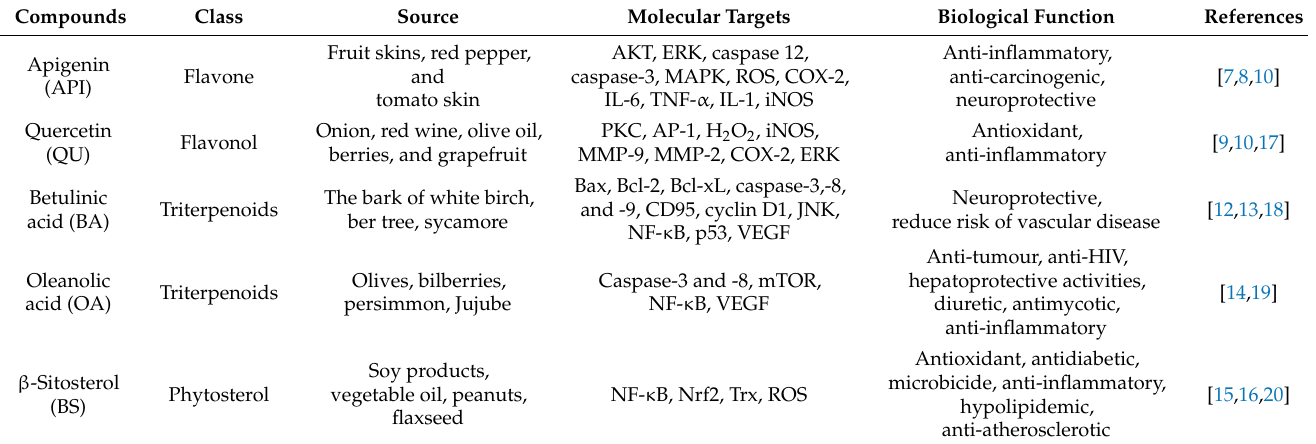
Table 1. Selected natural bioactive compounds, their molecular targets, and biological functions.